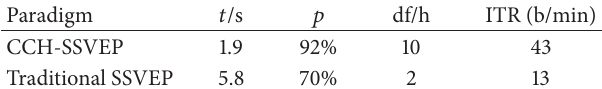
Table 1: Comparison of HFCC-SSVEP and traditional SSVEP. Paradigm 𝑡